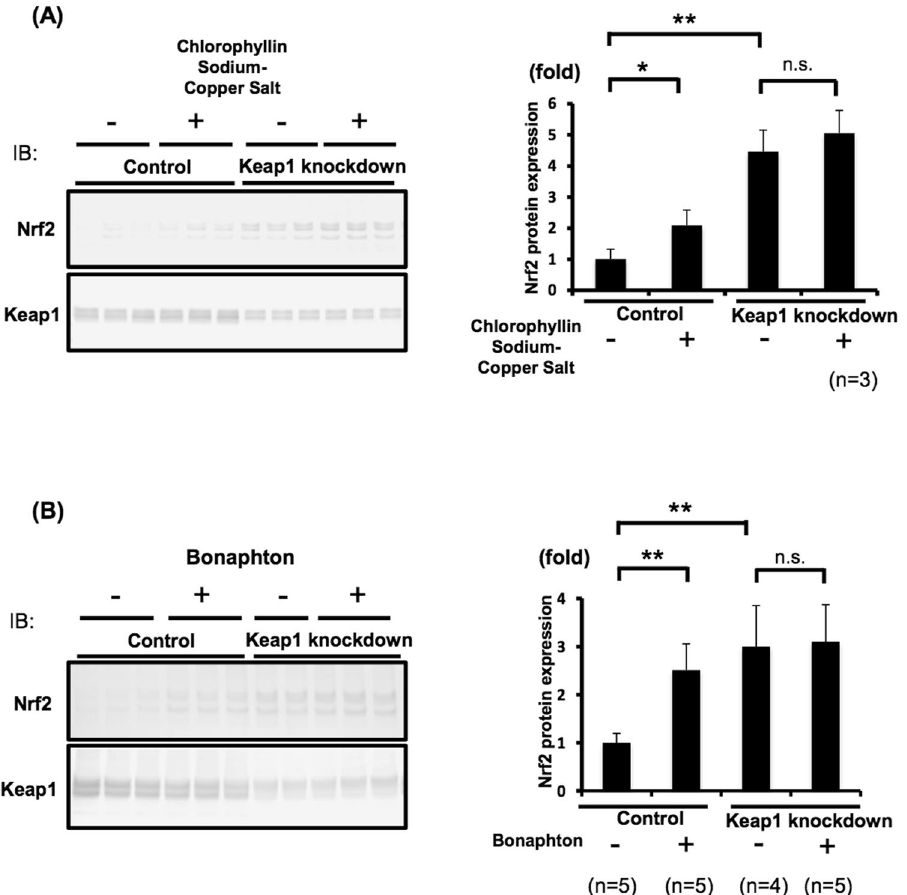
Figure 5. The effects of chlorophyllin sodium copper salt and bonaphton are depending on Keap1. HepG2 cells transfected with siRNA for Keap1 were treated with the two compounds. Protein expression levels of Keap1 were decreased by knock down, leading to increases of Nrf2 expression. The increases of Nrf2 by these compounds are not significant when Keap1 is knocked down, indicating that the effects of the compounds are depending on Keap1. ( A ) Left: Immunoblots of Keap1 knockdown cells treated with chlorophyllin sodium copper salt. Right: Densitometry analysis of Nrf2. ( B ) Left: Representing immunoblots of Keap1 knockdown cells treated with bonaphton. Right: Densitometry analysis of Nrf2 from total of 4–5 independent experiments. In densitometry analysis, values are expressed as the ratio to the average of the Nrf2 signals in the control group without compounds. * P < 0.05, ** P < 0.01. Full-length blots are presented in Supplementary Fig.